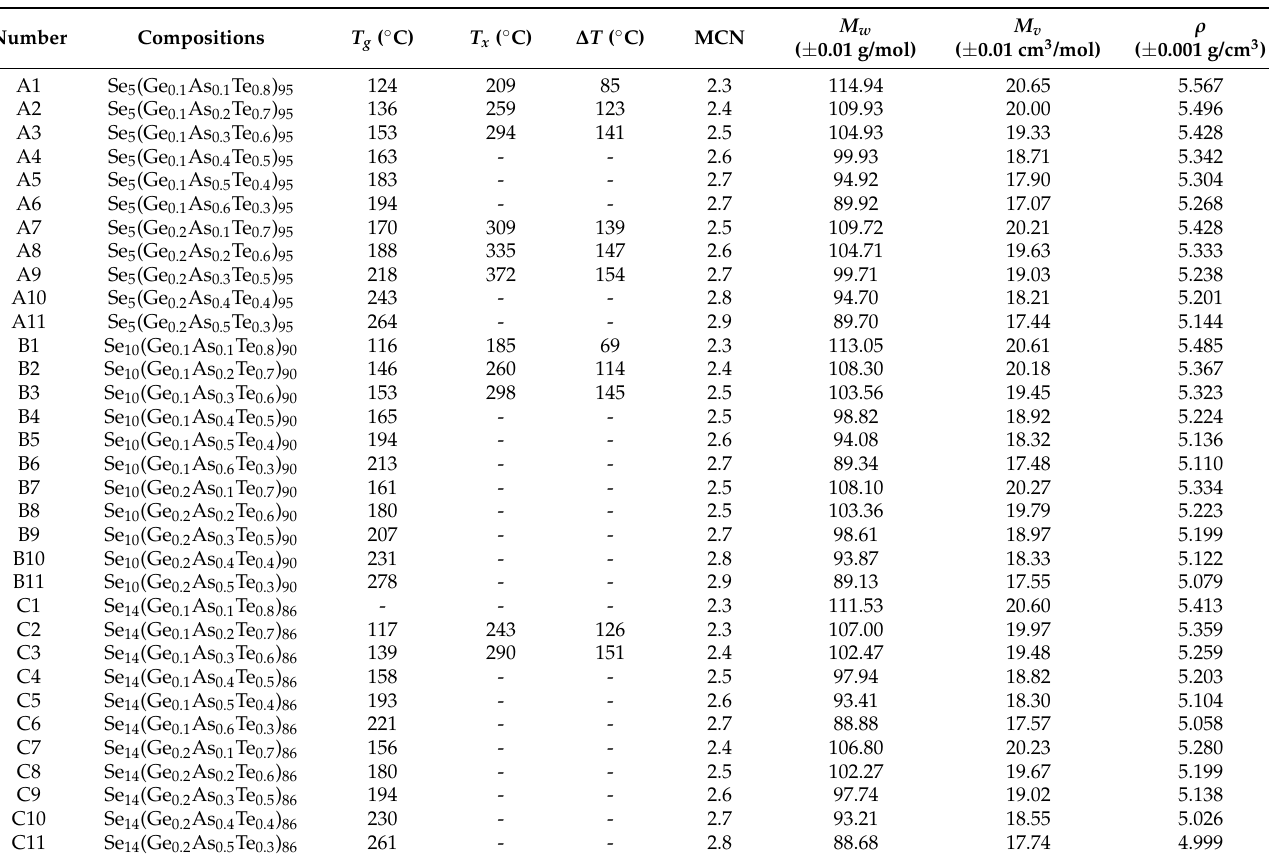
Table 1. DSC measurement results, mean coordination number (MCN), molar mass ( M w ), molar volume ( M v ), and density ( ρ ) of GAST